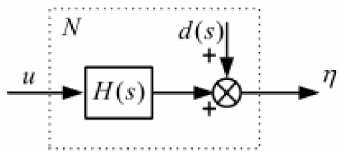
Figure 10. The nonlinear model of gear clearance.